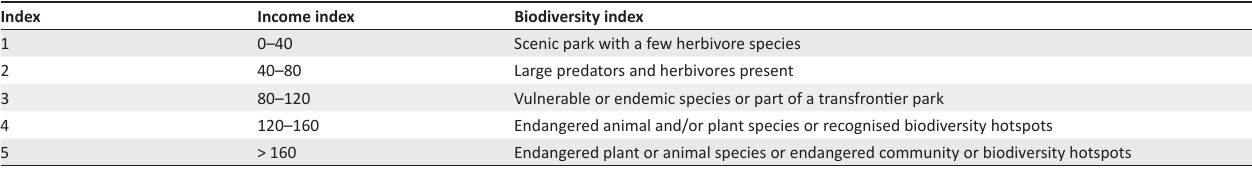
TABLE 2: Indices used to plot income against biodiversity for all parks managed by